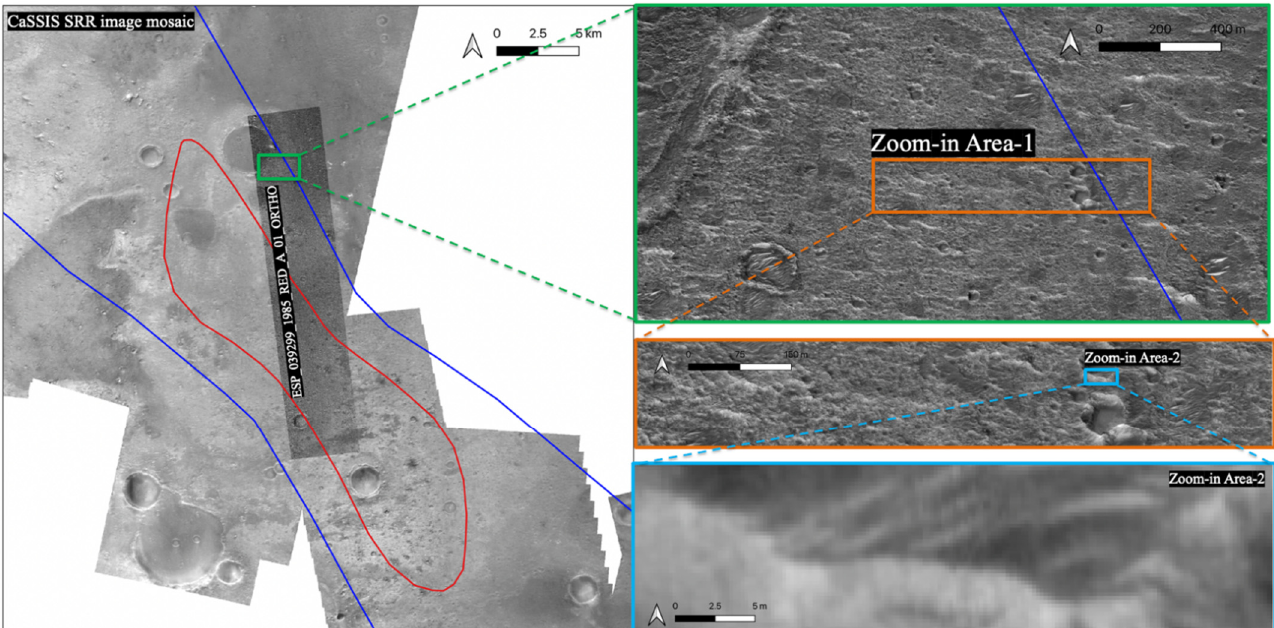
Figure 6. Locations of the exemplar zoom-in areas that are demonstrated in and Section 3.3. Left : 25 cm/pixel HiRISE PDS ORI (ESP_039299_1985_RED_A_01_ORTHO) superimposed on top of the resultant 1 m/pixel CaSSIS SRR image mosaic, superimposed by the 1-sigma (red) and 3-sigma (dark-blue) ellipses of the Rosalind Franklin ExoMars rover’s planned landing site at Oxia Planum; Right : multi-level zoom-in views of the same HiRISE PDS